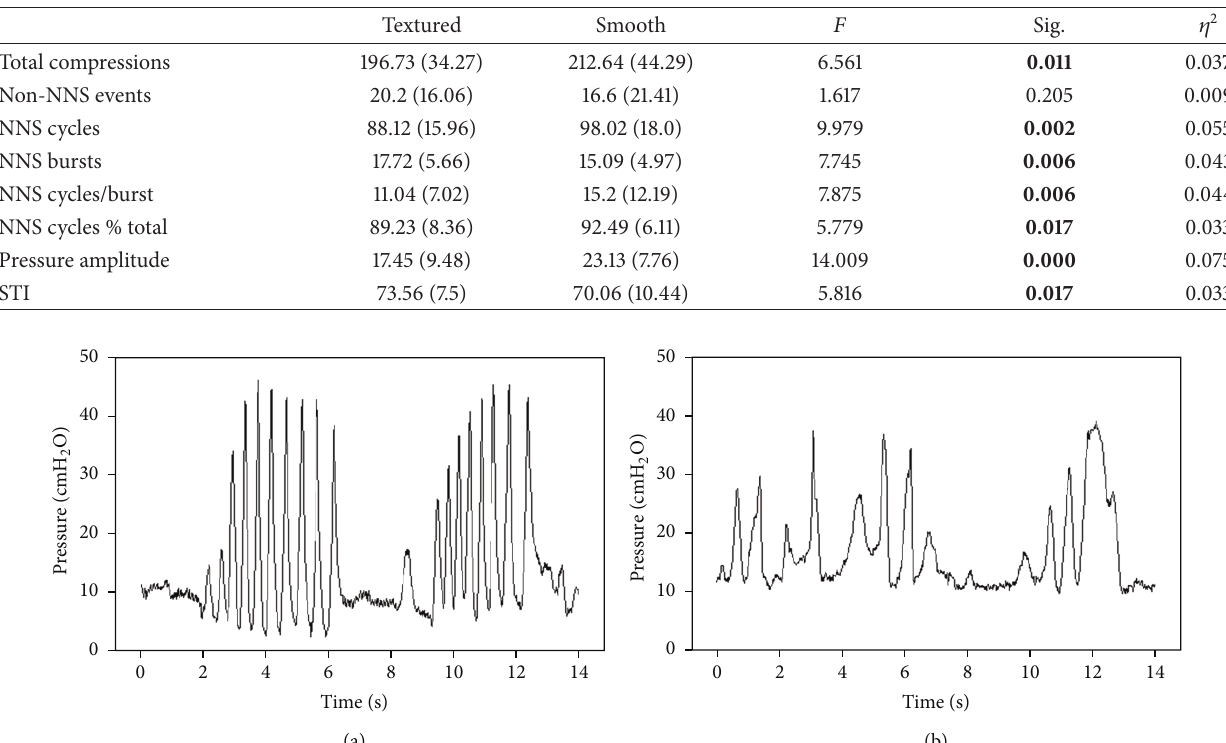
Table 3: Descriptive statistics for all measured variables when pooled across all textured pacifiers ( 𝑃 < 0.05).